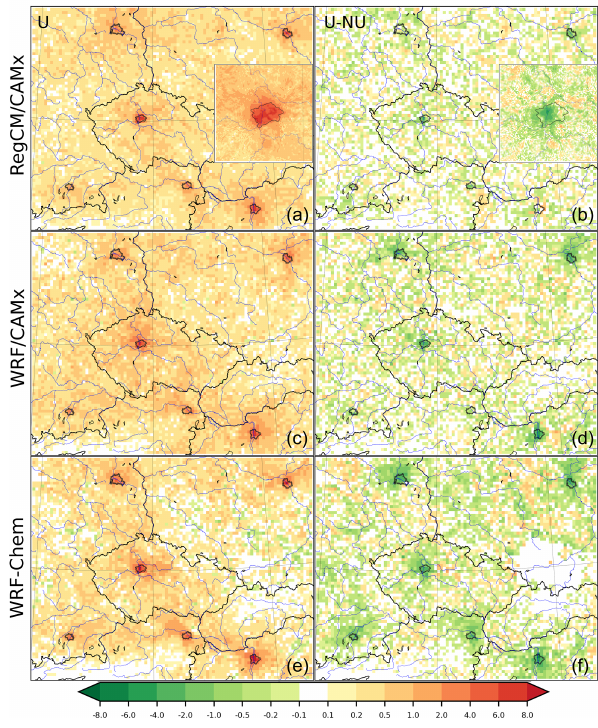
Figure 13. Same as Fig. 12 but for PM 2 . 5 (in µgm − 3 ). derestimation of PM 2 . 5 was also encountered in ˇ Doubalová